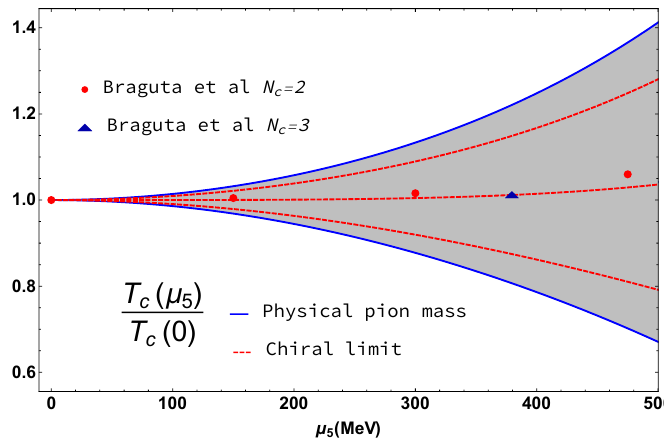
and j (cid:20) b j (cid:20) 1 16 (cid:25) 2 16 (cid:25) 2